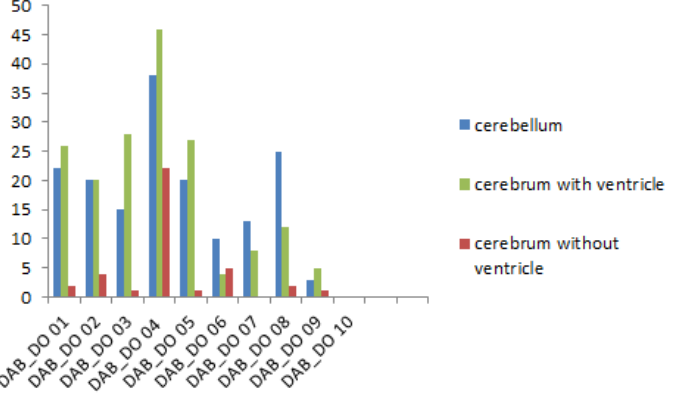
Figure 4. Parrot bornavirus (PaBV) antigen distribution in the brain of trial B group 1 (PaBV-4 inoculation in the yolk sac). The y -axis shows the number of PaBV antigen-positive cells counted in one slide (200 × total magnification). PaBV antigen was mainly found in the cerebellum and cerebrum with ventricles, and much less frequently in the cerebrum without ventricles. The x -axis shows each individual embryo ( n = 10, laboratory number).